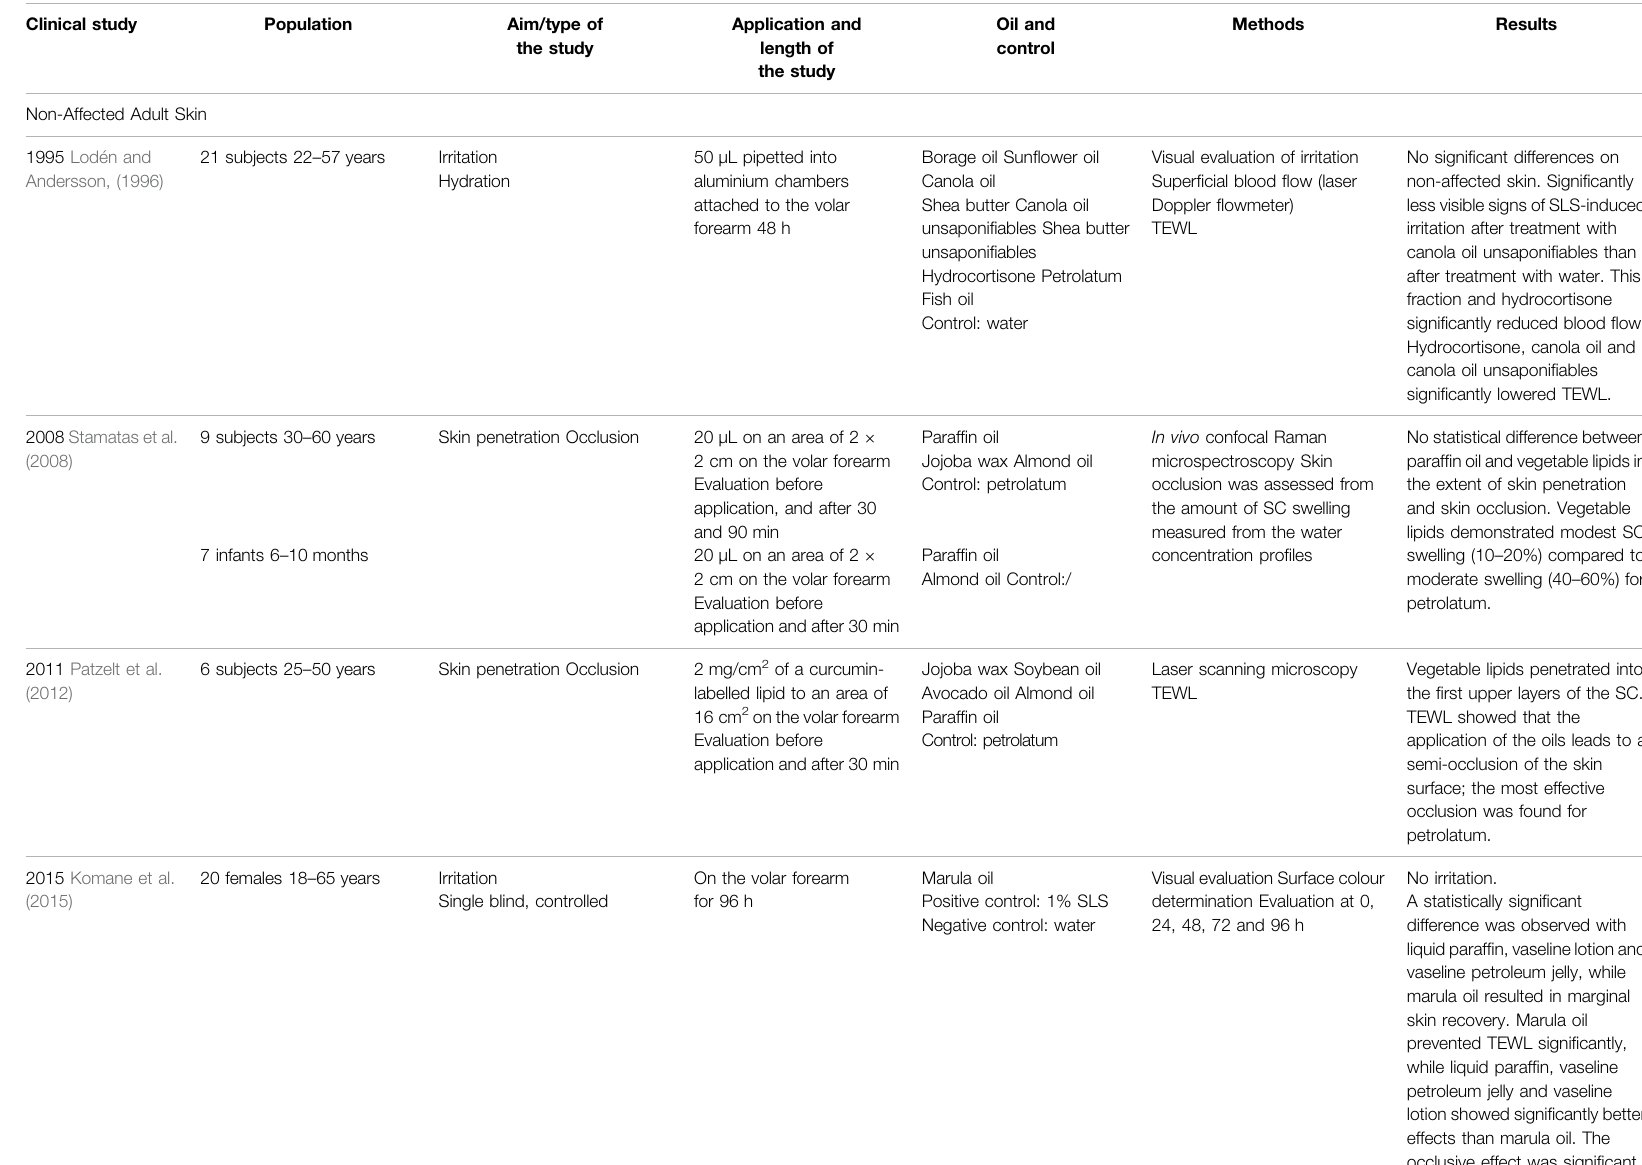
TABLE 4 | Clinical studies evaluating the dermal effects of vegetable butters and oils. AD — atopic dermatitis, GC — gas chromatography, MC — molluscum contagiosum , SA — Staphylococcus aureus , SC — stratum corneum, SG — striae gravidarum, SLS — sodium lauryl